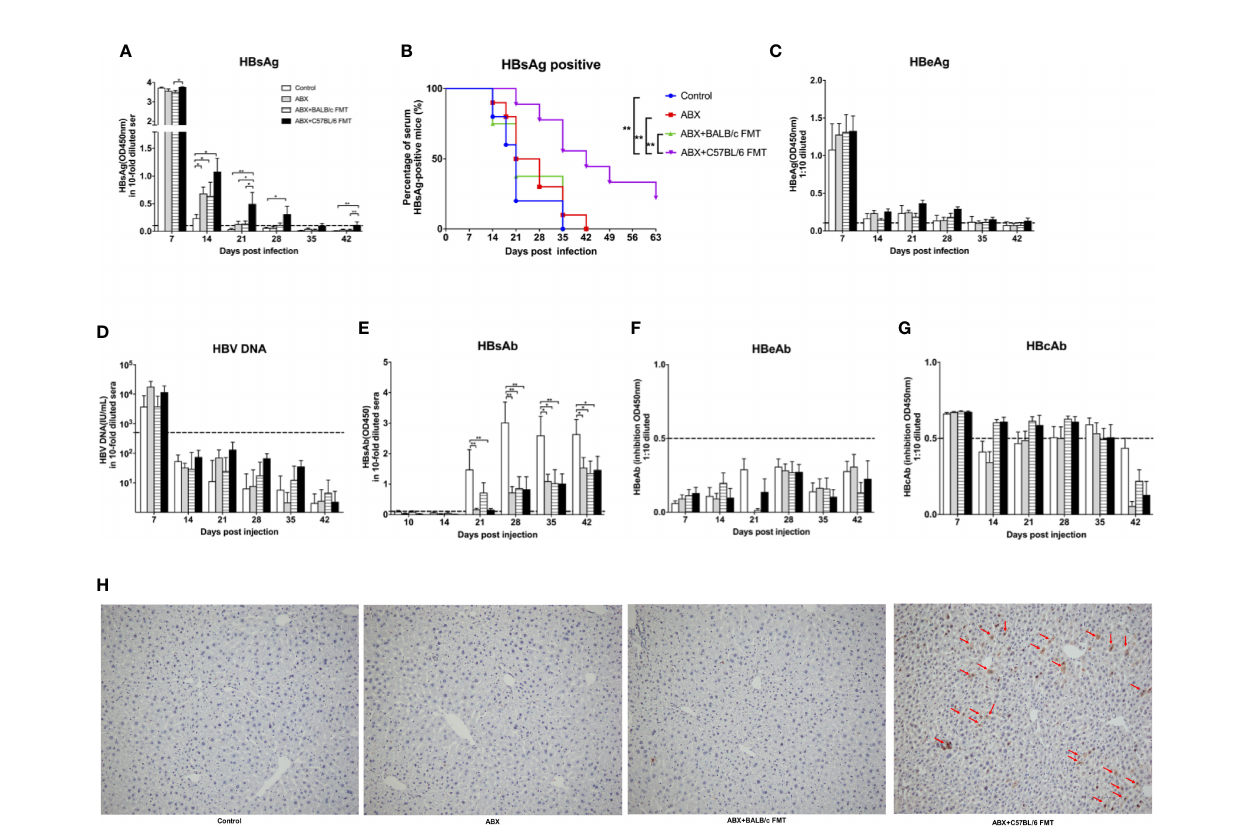
FIGURE 8 | ABX treatment and FMT alter HBV infection outcomes in BALB/c mice. After gut microbiota reconstitution, BALB/c mice were hydrodynamically injected with pAAV/HBV1.2 (as indicated in Figure 3A ). Serum levels of HBsAg (A) , HBeAg (C) , HBV DNA (D) , HBsAb (E) , HBeAb (F) , HBcAb (G) were measured at the indicated time points. (B) Kaplan – Meier curve showing the percentage of HBsAg-positive mice. Cutoff values are shown as dotted lines. (H) Mice were euthanized at 56 dpi, and HBcAg expression in the liver was measured by IHC staining. The HBcAg positive hepatocytes was labeled with red arrows. n = 10/group. * P < 0.05, ** P <